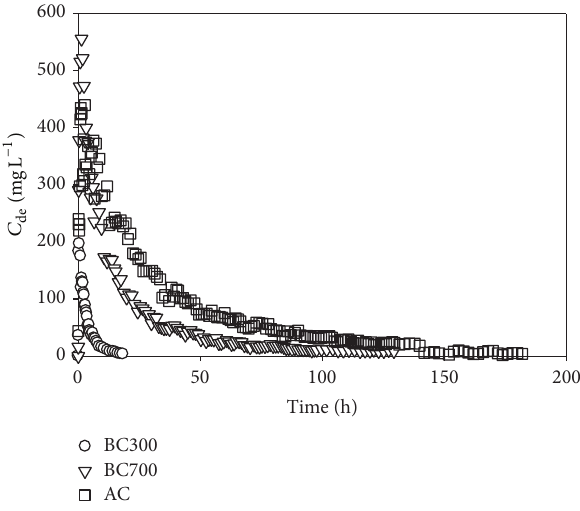
Figure 2: Elution curves for trichloroethylene (TCE) desorption from biochar derived from soybean stover pyrolyzed at 300 ∘ C (BC300) and 700 ∘ C (BC700) and activated carbon (AC).